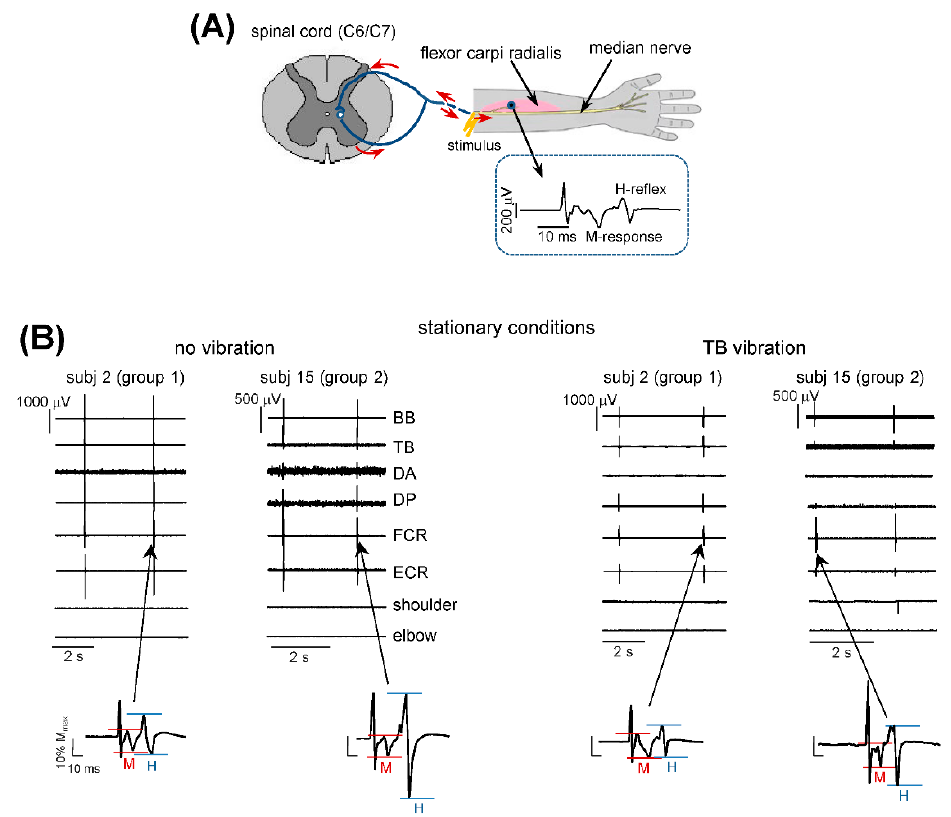
Figure 2. H-reflex measurements. ( A )—H-reflex was measured in the flexor carpi radialis muscle during electrical stimulation of the median nerve. ( B )—examples of waveforms of the H-reflex in two subjects (subj. 2 and 15 belonging to groups 1 and 2, respectively, see Figure 1C) during stationary conditions: left panels—no vibration, right panels—TB (triceps brachii) vibration. In the latter case, 2 stimuli were delivered after the onset of vibration but prior to the appearance of non-volun- tary arm movements (note the absence of noticeable EMG activity in all muscles). BB—biceps bra- chii, TB—triceps brachii, DA—deltoideus anterior portion, DP—deltoideus posterior portion, FCR—flexor carpi radialis, ECR—extensor carpi radialis. Lower panels show corresponding wave- forms of the M and H responses. The magnitude of M and H responses was marked by the red and blue horizontal lines, respectively. Note a significantly larger H-reflex in subj. 15 than in subj. 2 during the ‘no vibration’ condition. Since the H-reflex is typically modulated during stepping, during the movement con- ditions we applied stimuli at different phases of the cycle and compared the responses at similar amplitudes of angular motion (see Methods). For voluntary movements, we asked the subject to perform rhythmic arm movements with a cycle duration of ~2 s (similar to that during the non-voluntary rhythmic oscillations, Figure 1C), while, during passive movements, the same experimenter performed similar upper limb oscillations (9 ± 2° for the elbow, 19 ± 3° for the shoulder). The electrical stimulus was delivered to the median nerve every 5 s, which randomly occurred during different phases of movements, so that we grouped and analyzed the H-reflexes during four phases of movements. The onset of the cycle was defined as the maximum shoulder extension (Figure 3A). Figure 3B,C illus- trates the examples of the H-reflex measurements in four subjects during voluntary and passive movements, respectively. Note the larger H-responses in the subjects from group 2 (subj. 16 and 18) who demonstrated non-voluntary arm oscillations, than in the subjects from group 1 (subj. 2 and 4).